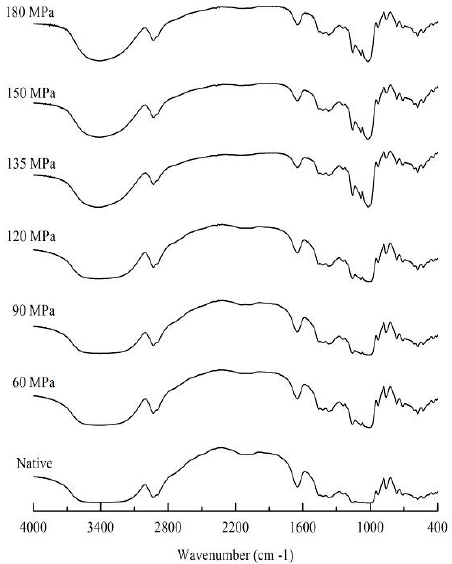
Figure 2. Fourier transformed infrared spectroscopy (FTIR) of native and pressurized LS.